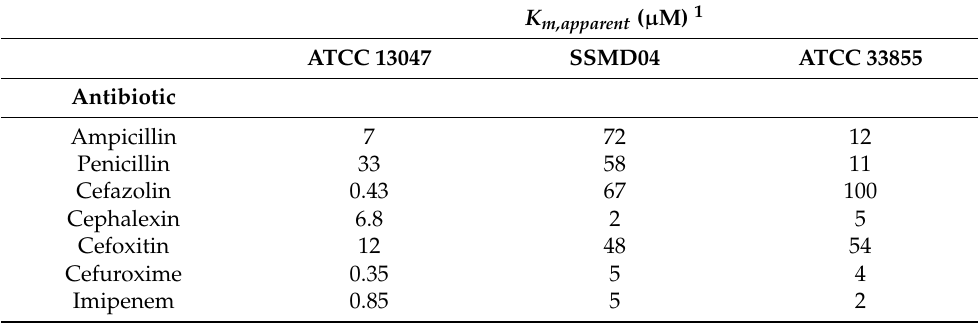
Table 2. K m,apparent of the poor substrates for the purified rAmpC enzymes from E. cloacae (ATCC 13047), C. neteri (SSMD04), and C. neteri (ATCC 33855) using nitrocefin as a reporter substrate. K m,apparent ( µ M)